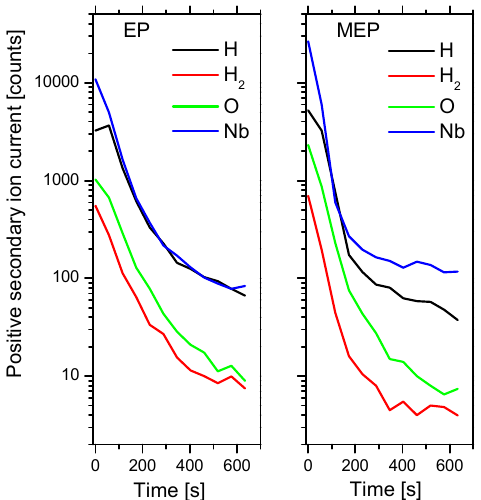
Figure 10. Results of rough SIMS depth analyses in the range of 900 s time of ion etching. Smoothed data: B-Spline.